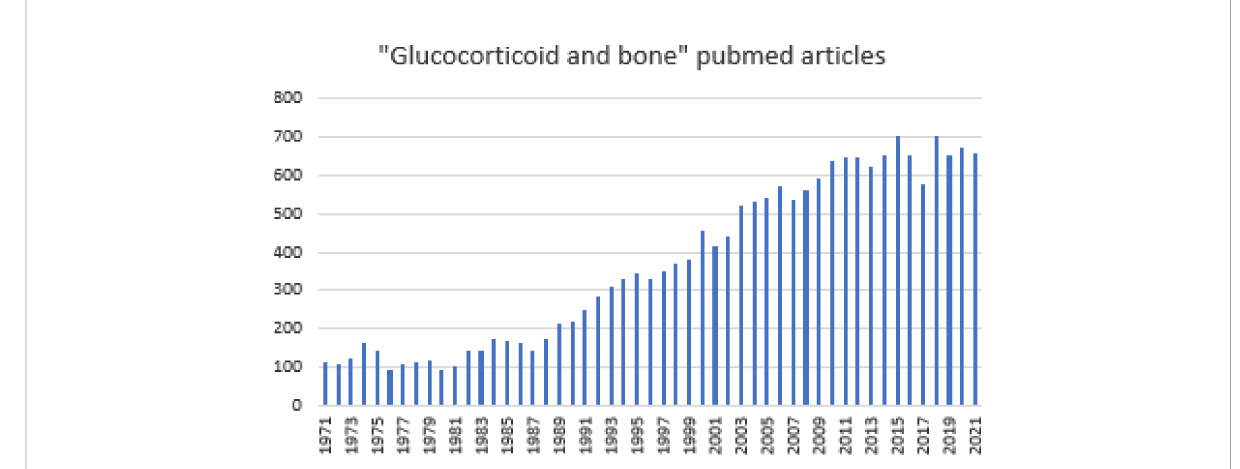
FIGURE 1 Number of publications listed in pubmed on "glucocorticoids and bone" over the last 50